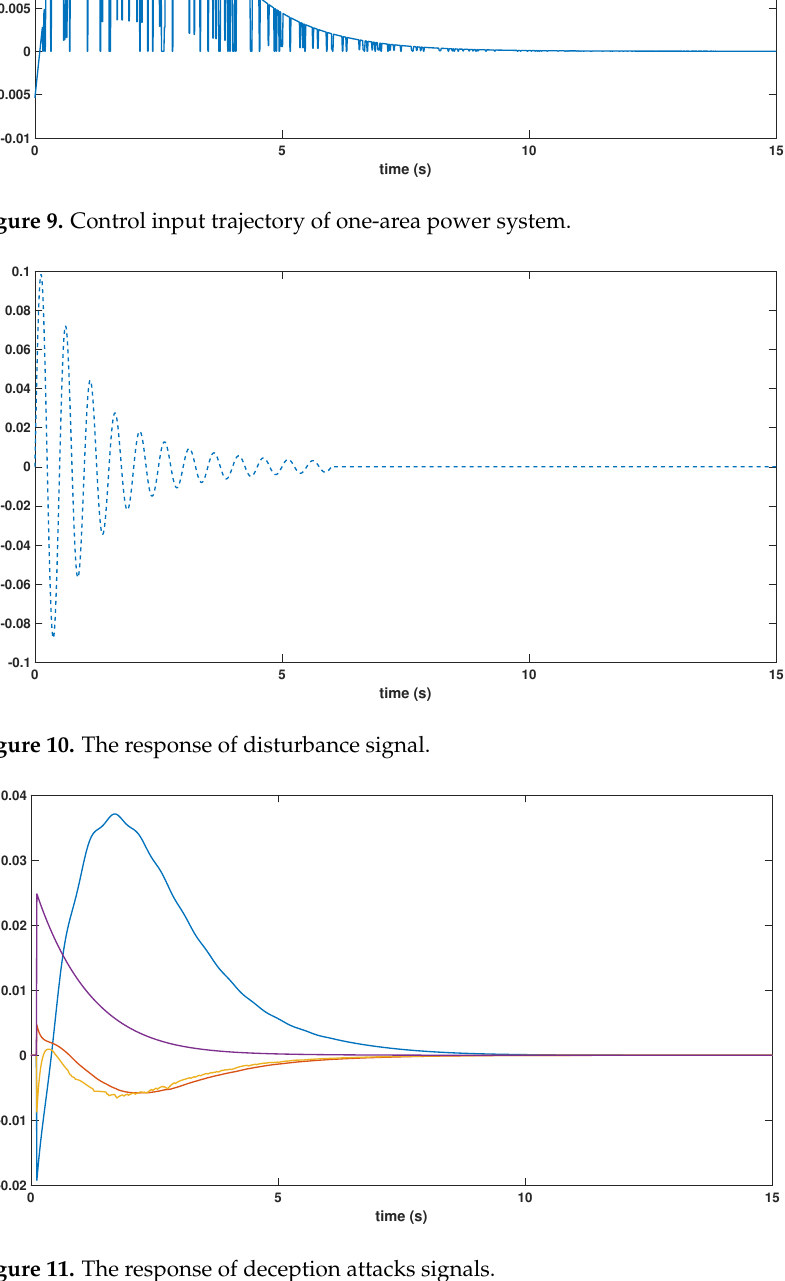
Figure 11. The response of deception attacks